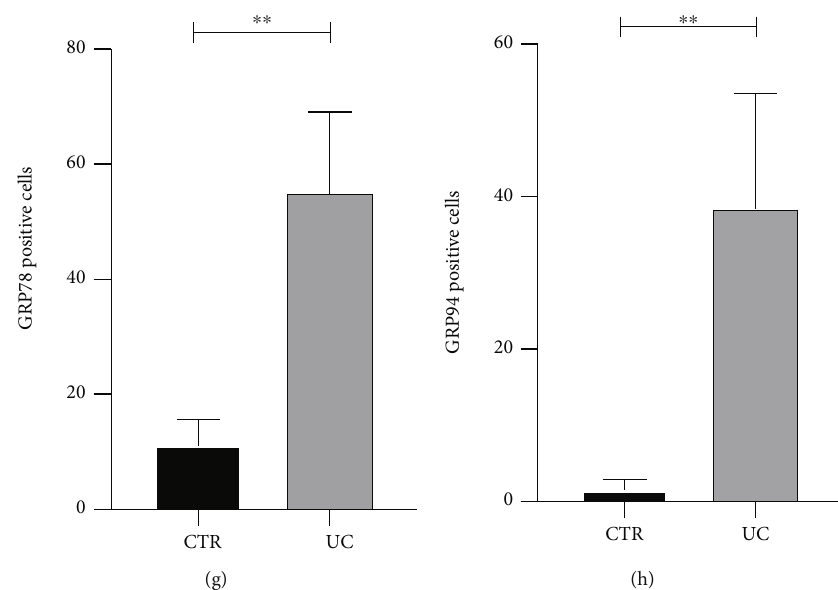
Figure 3: Activation of UPR-responsive genes and chaperone modulation. (a) Transcriptional levels of STC2, ATF3, and DDIT3 are shown as a fold change; ∗ p < 0 : 05 , ∗∗ p < 0 : 005 . (b) Quantitative analysis of immunohistochemistry staining for DDIT3 of both groups. For UC, n = 6 ; for CTR, n = 3 ; ∗ p < 0 : 05 . (c) Immunohistochemical analysis of DDIT3 was performed on para ffi n-embedded slides from intestinal mucosa of both UC and CTR groups. The arrows indicate DDIT3-positive cells, which are shown in brown. The white arrows indicate positive epithelial cells, and the black arrows signalize positive cells from the lamina propria. Scale bars: 50 μ m. (d) Transcriptional levels of the chaperones DNAJC3, CALR, HSPA5, and HSP90B1 are shown as fold change, ∗∗ p < 0 : 005 . (e, f) Immunohistochemical analysis of GRP78 and GRP94 was performed on para ffi n-embedded slides from intestinal mucosa of both groups. The arrows indicate GRP78- and GRP94-positive cells, which are shown in brown. The white arrows indicate positive epithelial cells, and the black arrows signalize positive cells from the lamina propria. Scale bars: 50 μ m. (g, h) Quantitative analysis of immunohistochemistry staining for GRP78 and GRP94 of both groups. (g) For UC, n = 8 ; for CTR, n = 5 ; ∗∗ p < 0 : 005 . (h) For UC, n = 6 ; for CTR, n = 4 ; ∗∗ p < 0 : 005 . CTR=control; UC=ulcerative transcription factor-3 (ATF3) ( p < 0 : 05 ), and DDIT3 ( p < 0 : 05 ) (Figure 3(a)). In addition, we observed marked immunoreactivity for DDIT3 protein in the colonic epithe- lial cells of UC patients (Figures 3(b) and 3(c)), corroborat- ing the DDIT3 transcriptional fi ndings.